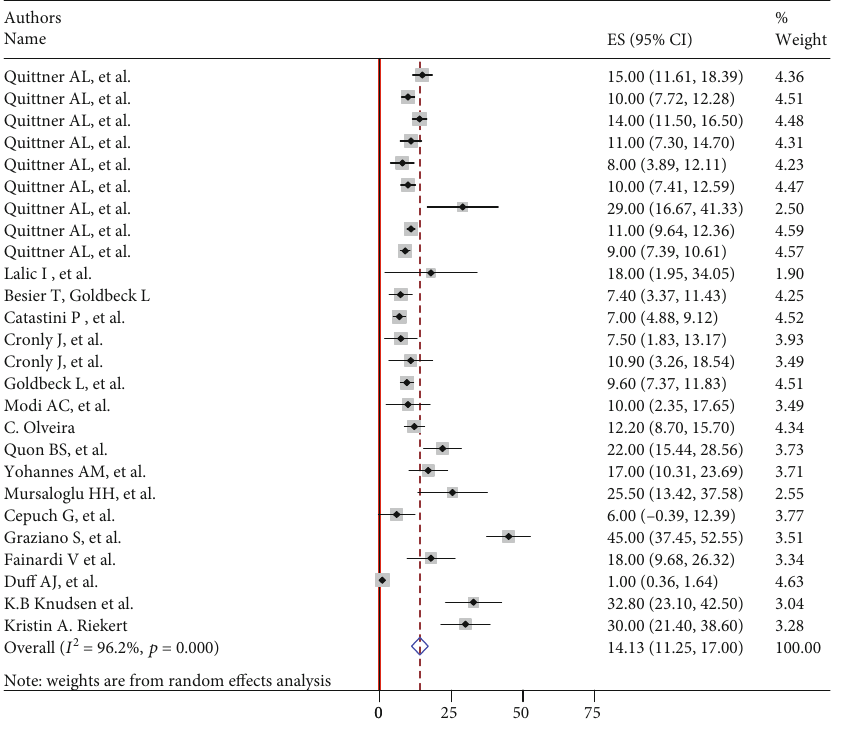
Figure 3: Forest plot showing global pooled prevalence of depression in patients with cystic fi